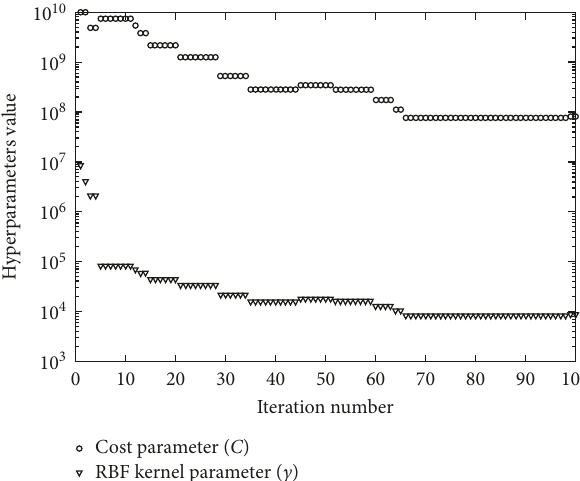
Figure 4: The iterative process of hyperparameters selection.